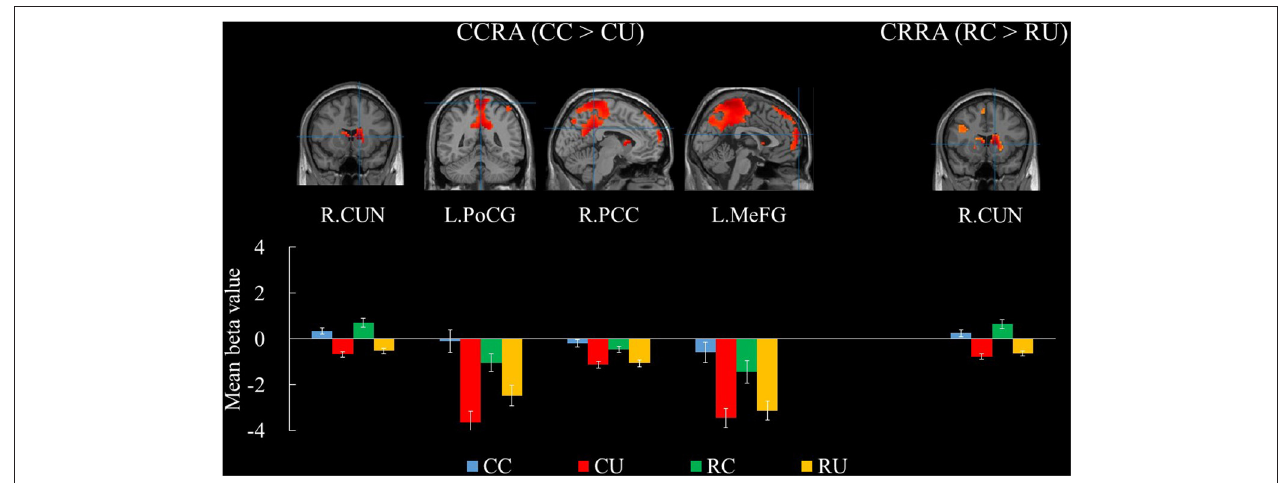
FIGURE 1 | Brain regions for Chinese Compound or Radical Remote Associations. The bars show the mean beta values of the peak voxels for each of the four conditions. Error bars represent standard error of the mean. L, left; R, right; CUN, caudate; PoCG, postcentral gyrus; PCC, posterior cingulate cortex; MeFG, medial frontal gyrus; CCRA, Chinese Compound Remote Association; CRRA, Chinese Radical Remote Association; CC, Chinese Compound Remote Associates Test-Correct; CU, Chinese Compound Remote Associates Test-Unsolved; RC, Chinese Radical Remote Associates Test-Correct; RU, Chinese Radical Remote Associates Test-Unsolved.